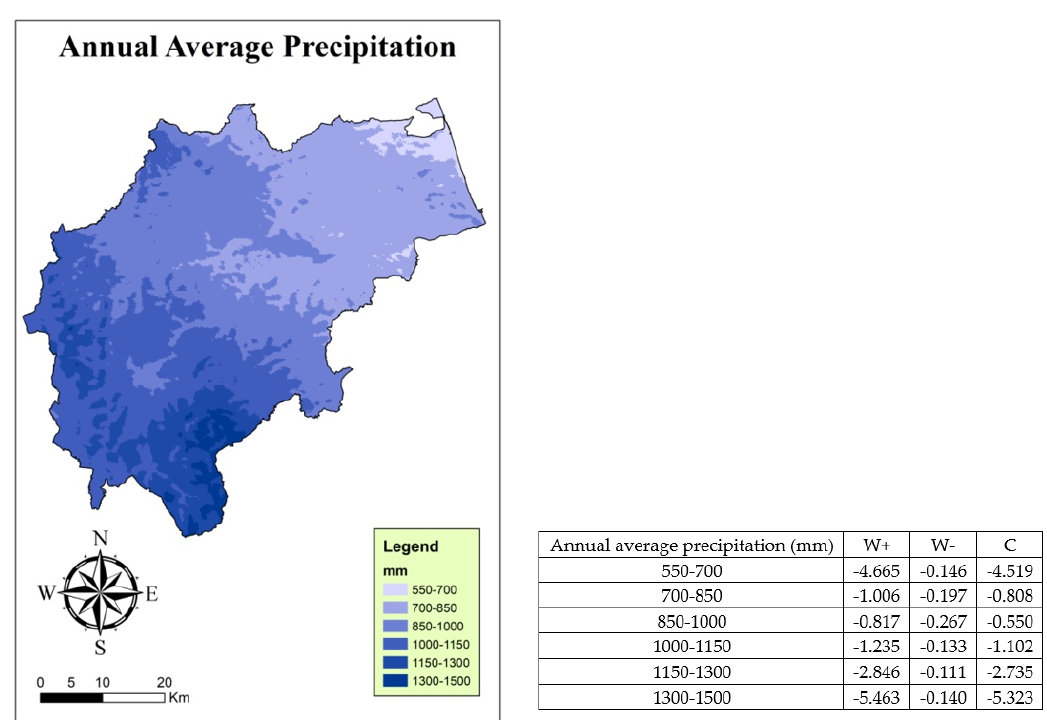
Figure 7. ( Left ) Land use of Macerata province, from Corinne Land Cover; ( Right ) The weights calculated for the land use parameter.